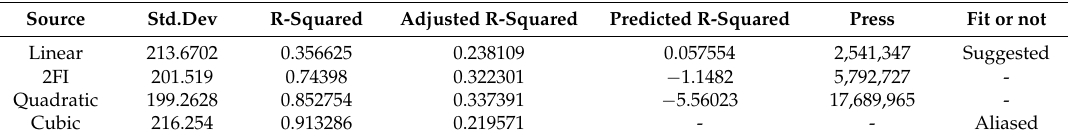
Table 5. Statistical approach to select the RSM model for SLA.